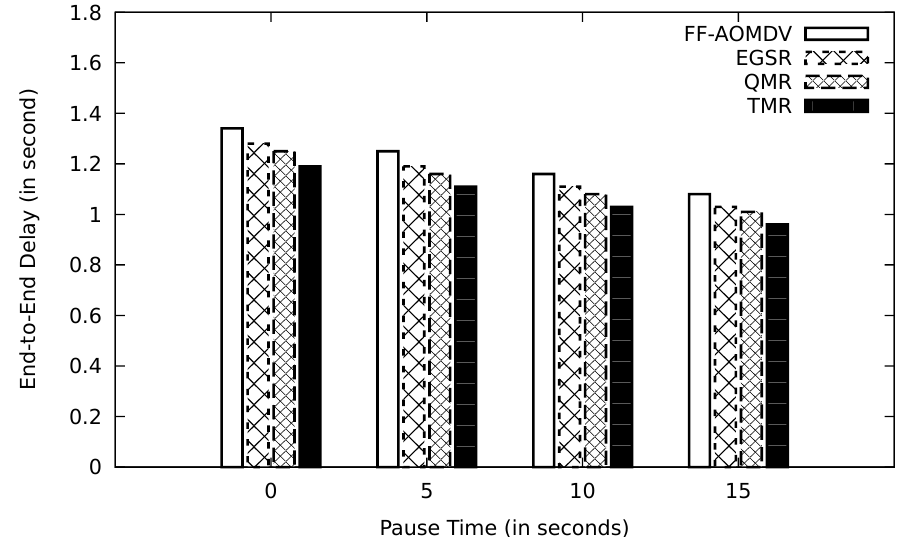
Figure 7. Comparison of FF-AOMDV, EGSR, QMR, and proposed protocol TMR for end-to-end delay with pause time.